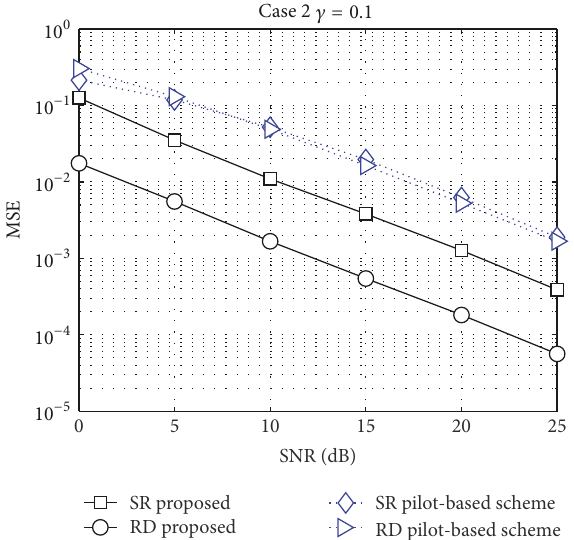
Figure 8: MSE performance with different schemes for Case 2 .